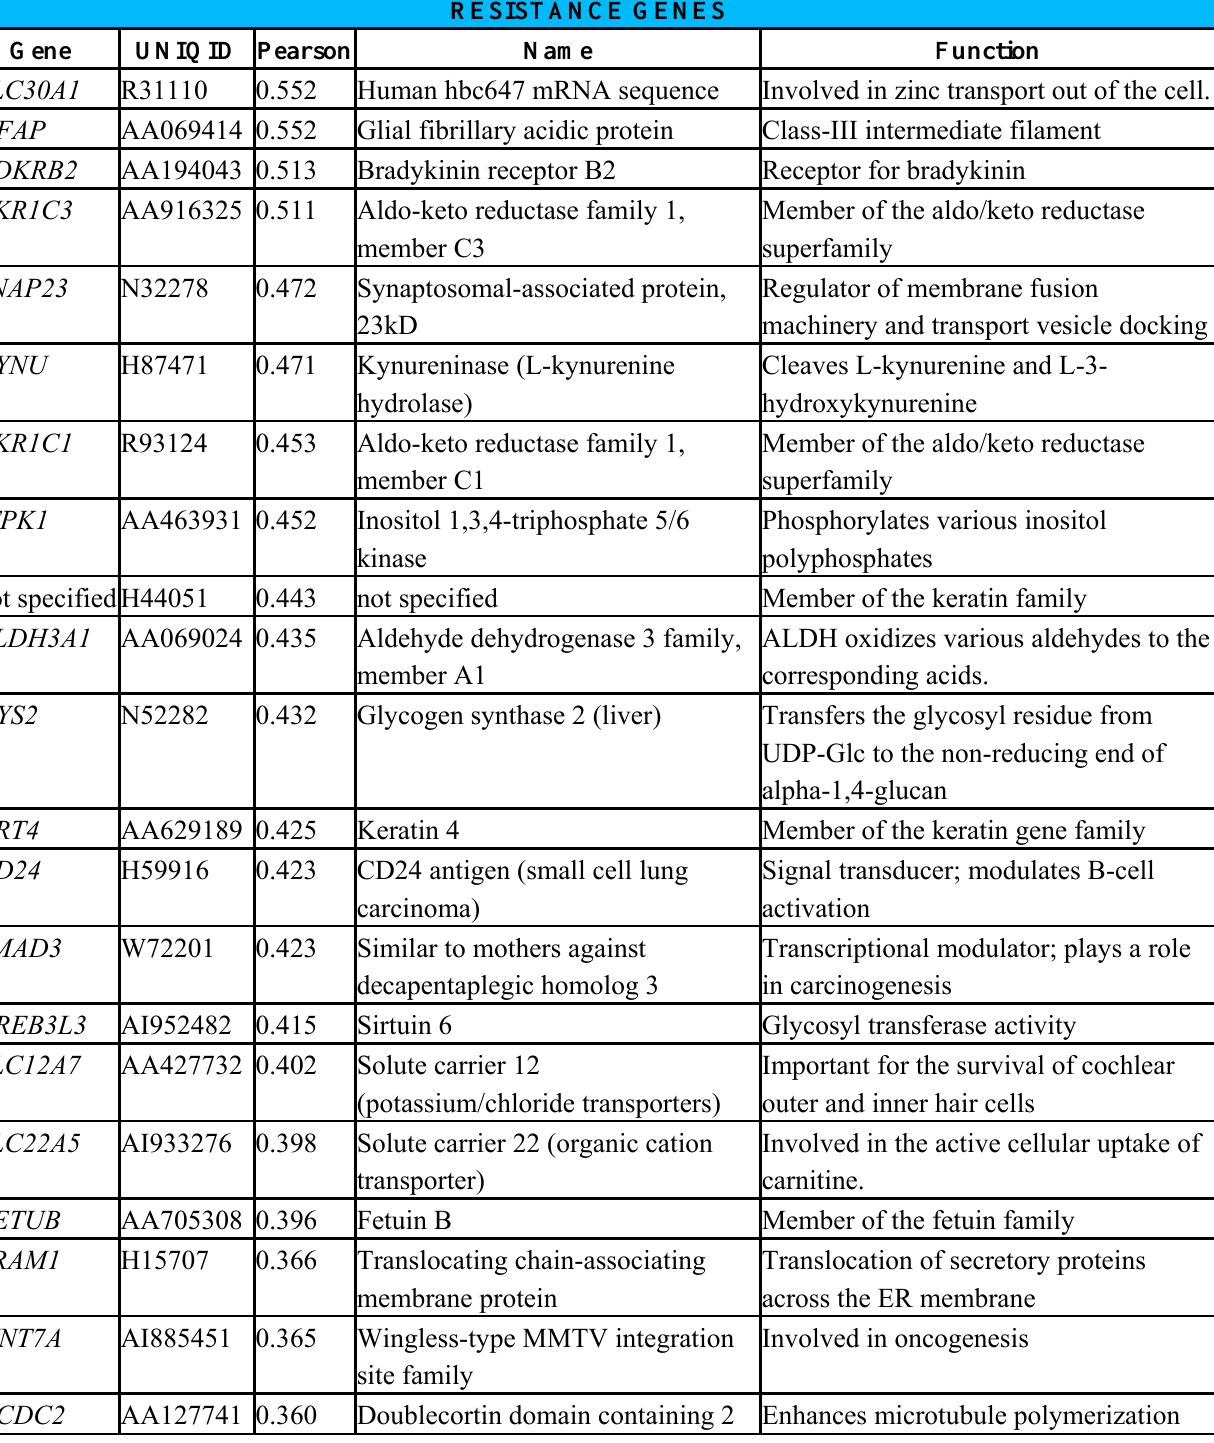
Table 1. Genes determining sensitivity or resistance towards ART in the panel of 39 cell lines as identified by microarray mRNA expression profiling and COMPARE